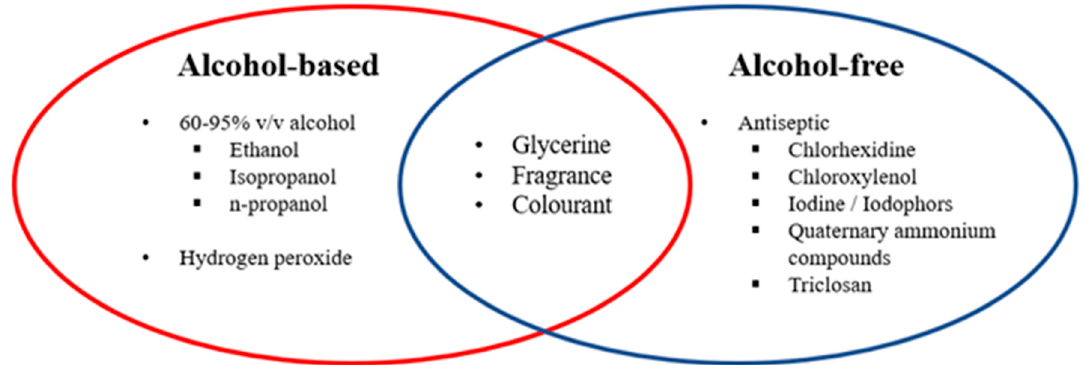
Figure 2. List of alcohol, non-alcohol compounds, and commonly used excipients in hand